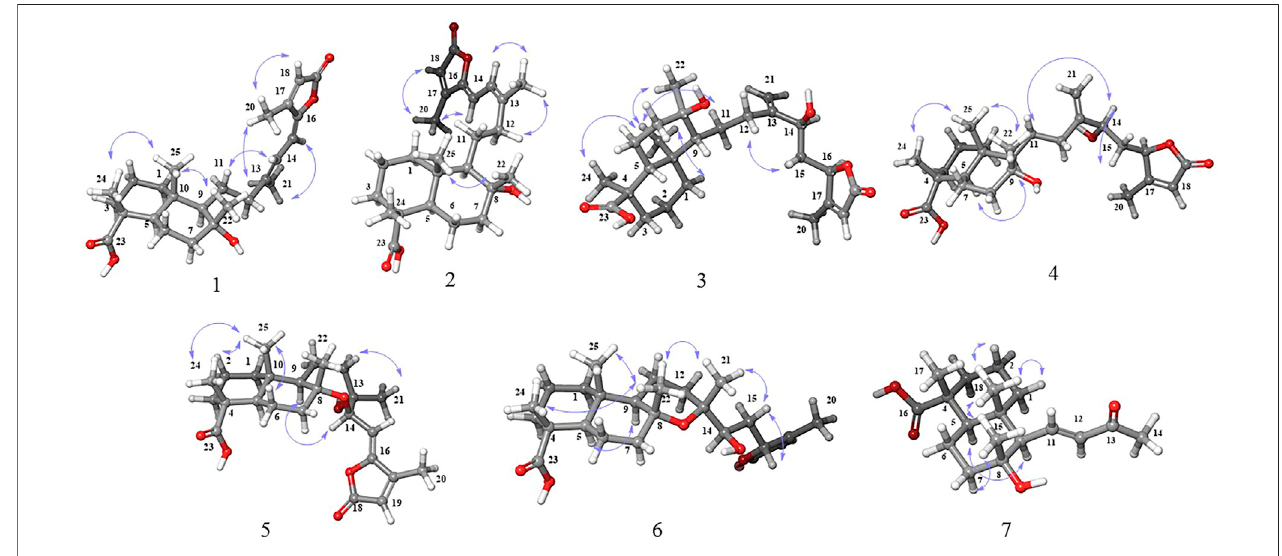
FIGURE 3 | NOESY (H ↔ H) correlations of compounds 1-7 .